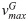
Model predictions and observations of Escherichia coli acclimation to growth on glucose.Top panel—Modeled and experimental abundances of the glucose transporter PtsG across steady-state concentrations of glucose (log scale). Contours indicate the corresponding uptake rates. The vertical green dashed line represents the critical substrate concentration S*. nmax is above the plotted range. Bottom panel—Modeled and experimental uptake rates over an interval of glucose concentrations. The uptake rate profile for a glucose-replete batch acclimated culture is shown in cyan. Uptake rates for all acclimated phenotypes over the concentration range are shown in red, with model predictions shown as a continuous line and experimentally derived values from published data [15] shown as markers. For guidance, the maximum diffusive flux is shown as a dashed blue line, S* is shown as a vertical dashed green line, and vmaxG is indicated by the horizontal dashed orange line.